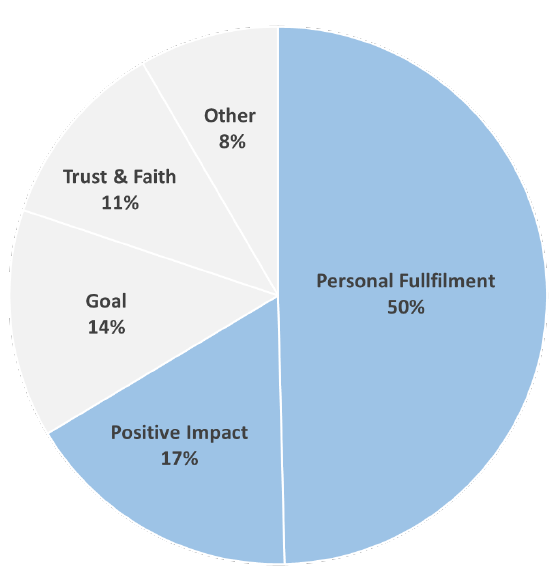
Fig. 2. Left: Perceived current operating paradigm and desired operating paradigm represented as totals for each paradigm. Right: Absolute values and percentages for organisations and individuals. The groups are significantly different (p < 0.0001).